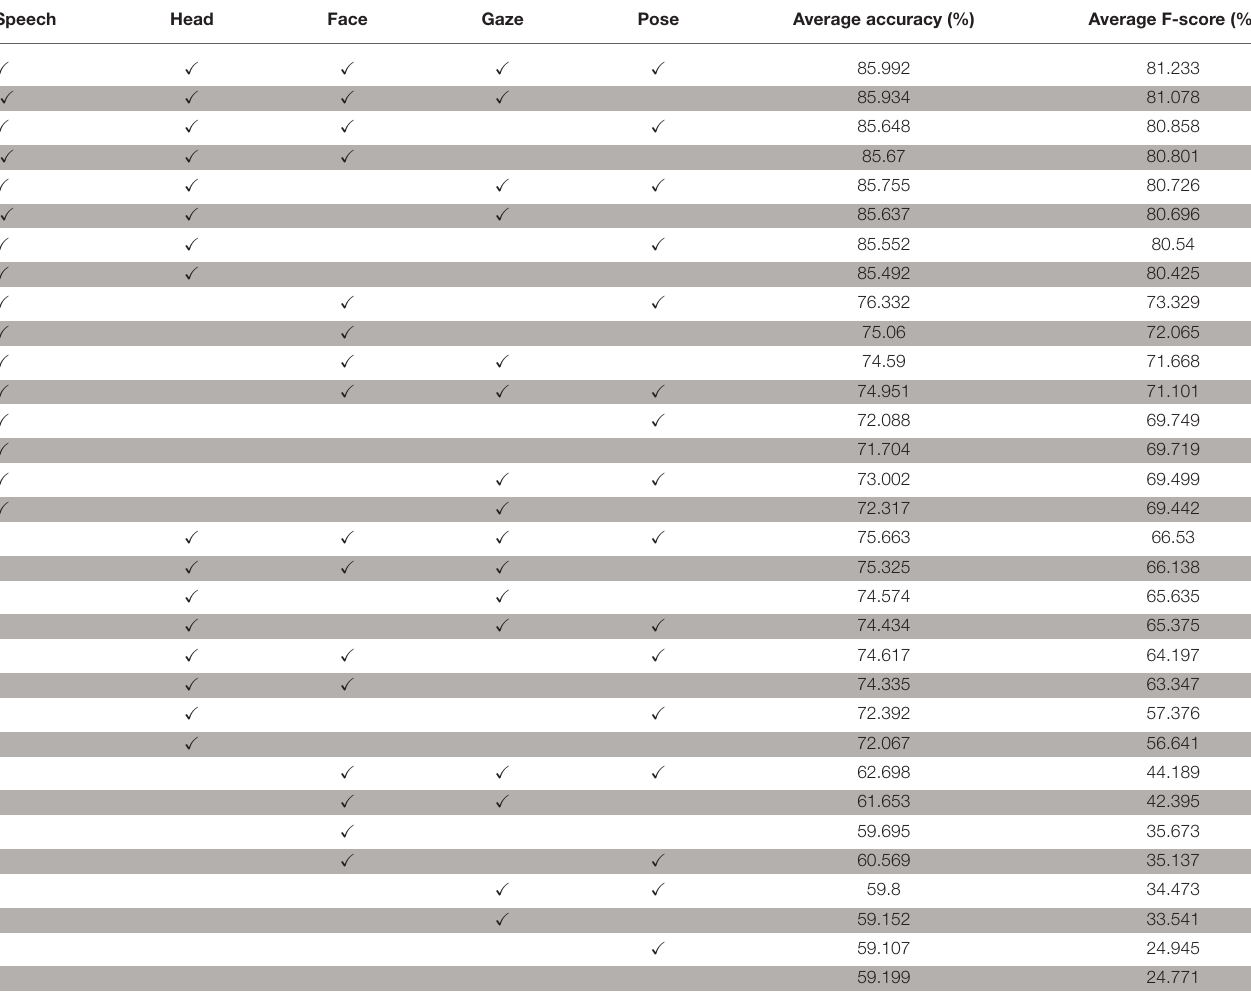
TABLE 4 | An ordered presentation of F-scores and accuracies when random forest models are not given certain modalities.